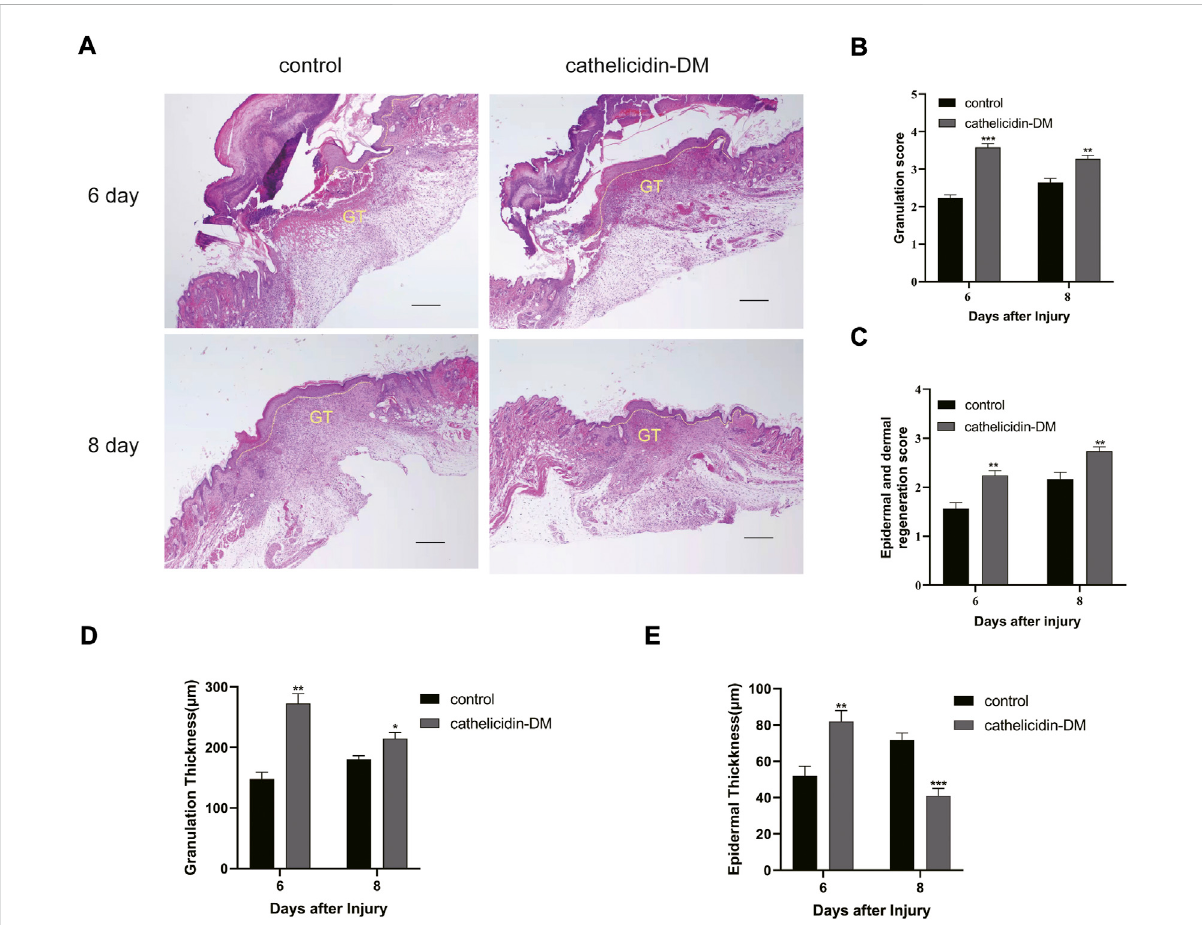
FIGURE 5 Histopathologicalexaminationofwoundsinmice. (A) Effectofcathelicidin-DMonskinre-epithelializationandgranulationtissueinmice(note: dashedlinerepresentsreepithelialization,GTrepresentsgranulationtissue,barsindicate200 μ m). (B – E) Histologicalscoresofgranulationthickness, epidermis and dermis regeneration; granulation and epidermal thickness of mice. Values represent means ± standard ( n = 3). * p < 0.05, ** p <